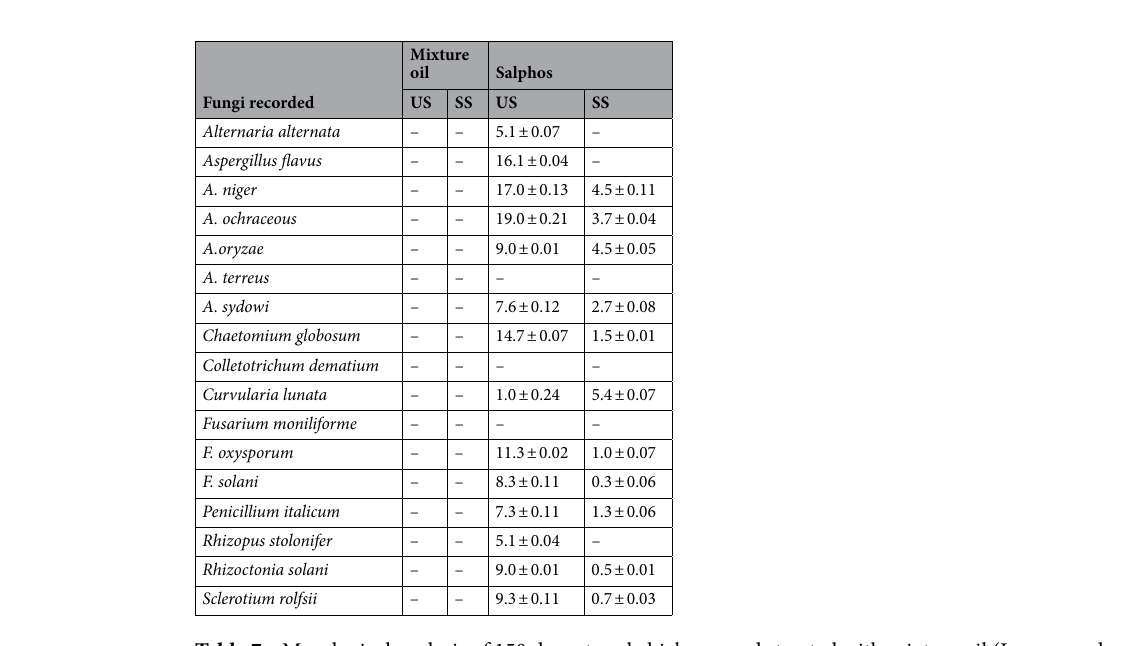
Table 7. Mycological analysis of 150 days stored chickpea seeds treated with mixture oil (Lavang and sowa leaf oil) and salphos. US unsterilized seeds, SS sterilized seeds, SD standard deviation. –: Absence of fungal species. *Values given are mean of three